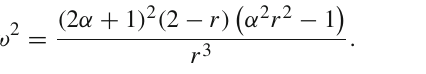
Right panel: NUT2-solution of Eq. (16). The characteristic frequencies are defined in Eq. (17). Curves ω ± = constant, defining the MB s are shown in the extended plane l − r , for θ = π/